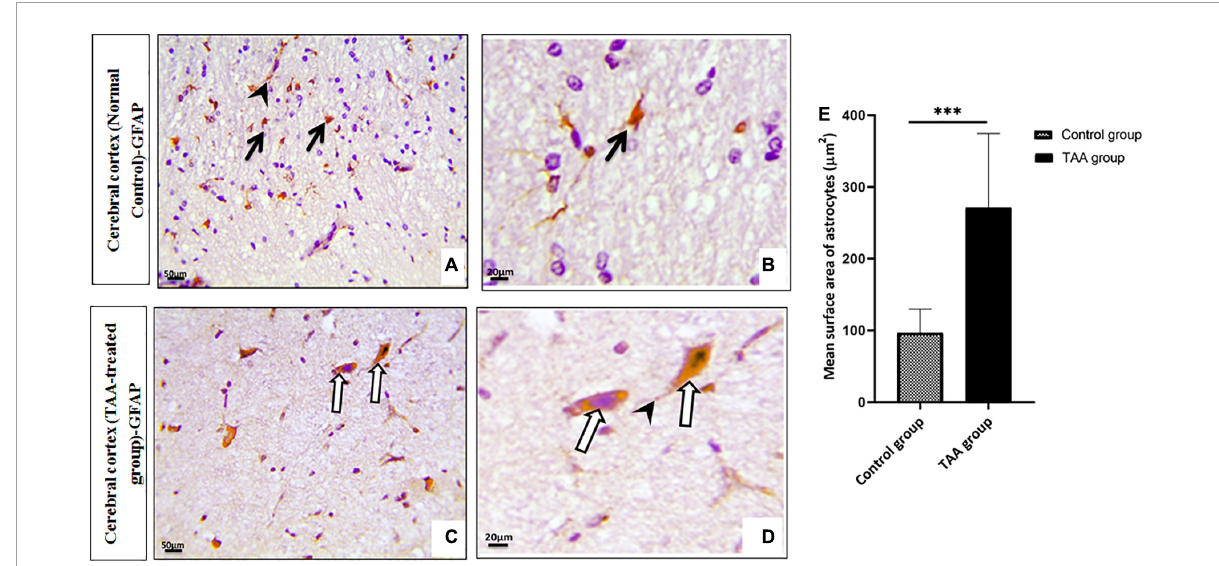
FIGURE7 (A–D) Microscopic pictures of immunostained cerebral cortical sections against GFAP of control and treated groups. (A,B) Control group showing positively brown stained astrocytes (black arrows) with evident expression in their processes (arrowhead). (C,D) Cerebral cortical sections from the TAA-treated group showing hypertrophied astrocytes (white arrows) and processes (arrowhead). X: 400 bar 50 and X: 1000 bar 20. (E) Graph showing mean surface area of astrocytes. Values represent mean ± SD ( ∗∗∗ p < 0.001 vs. control group).